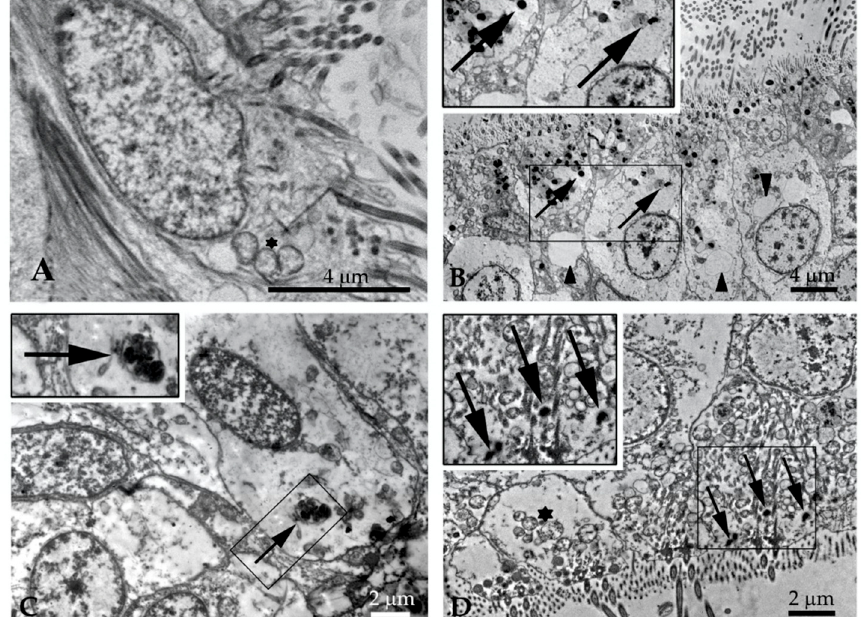
Figure 2. Images obtained by transmission electron microscopy (TEM) of M. galloprovincialis gill biopsy exposed to NPs. ( A ) Control. ( B ) 10 μ g/mL Hydrophilic CB-derived nanoparticles (HNP). ( C ) 50 μ g/mL of P25. ( D ) 50 μ g/mL of MT. Magnified fields with arrows indicate electron-dense particles in exposed cells. Arrowhead points to cytoplasmic vacuoles. indicates mitochondria.